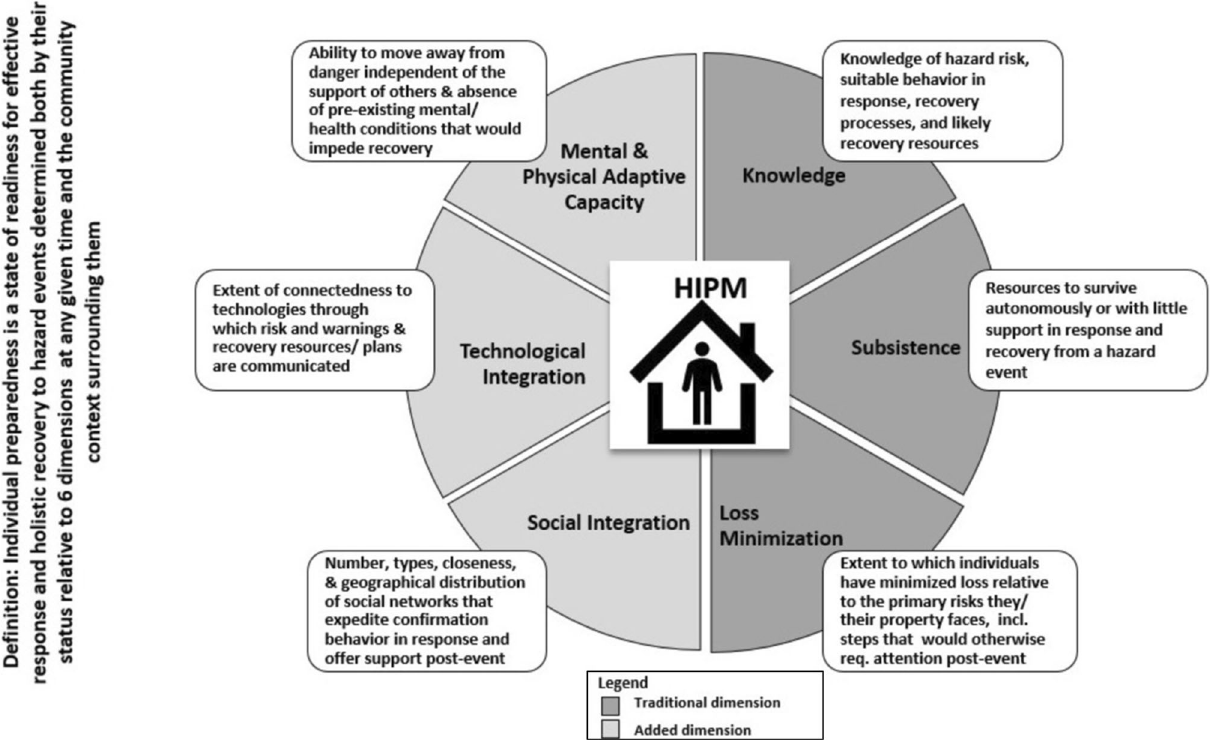
Fig. 1 Holistic Individual Preparedness Model (HIPM). Source Jensen